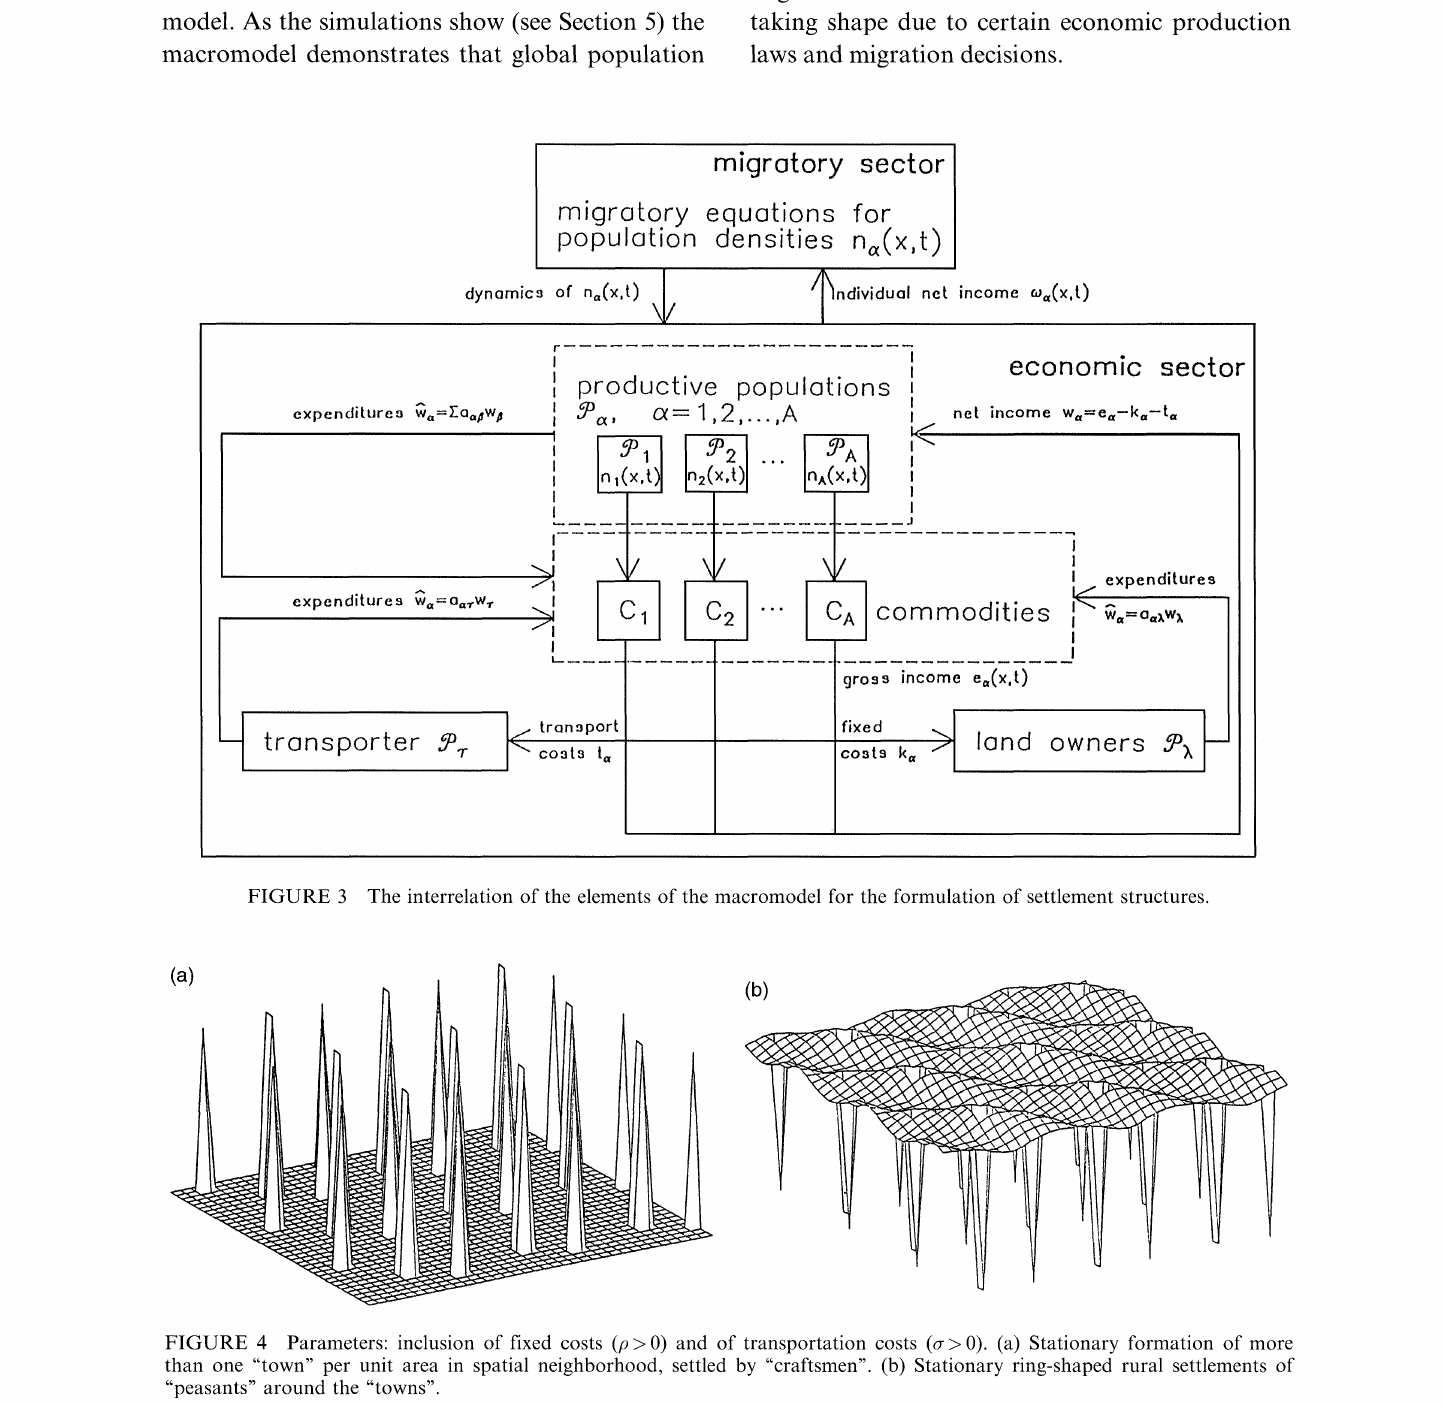
FIGURE 4 Parameters: inclusion of fixed costs (p > 0) and of transportation costs (a > 0). (a) Stationary formation of more than one "town" per unit area in spatial neighborhood, settled by "craftsmen". (b) Stationary ring-shaped rural settlements of "peasants" around the